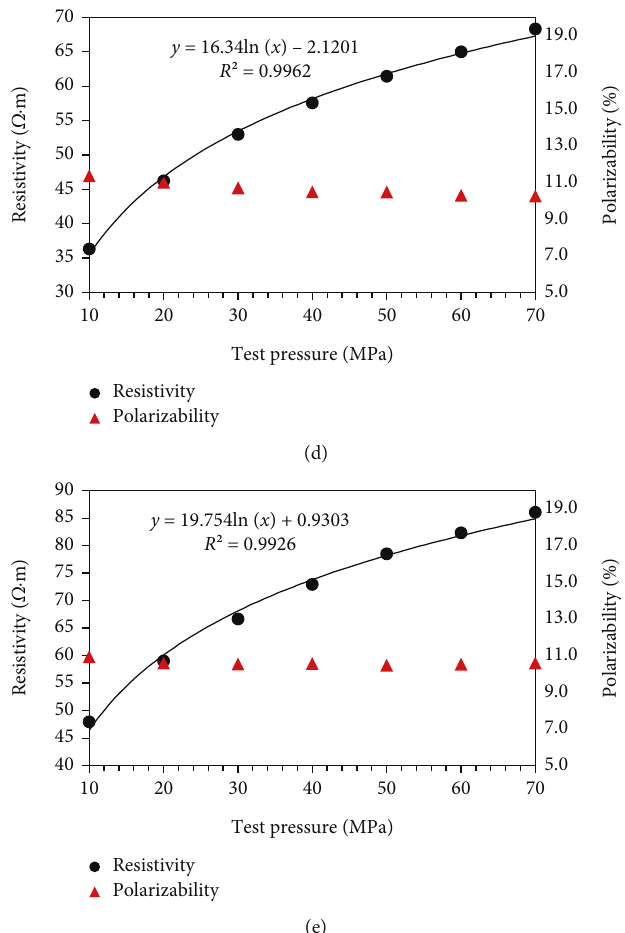
Figure 9: (a – e) The complex resistivity inversion results for samples 1, 2, 3, 4, and 5 under di ff erent pressure conditions,